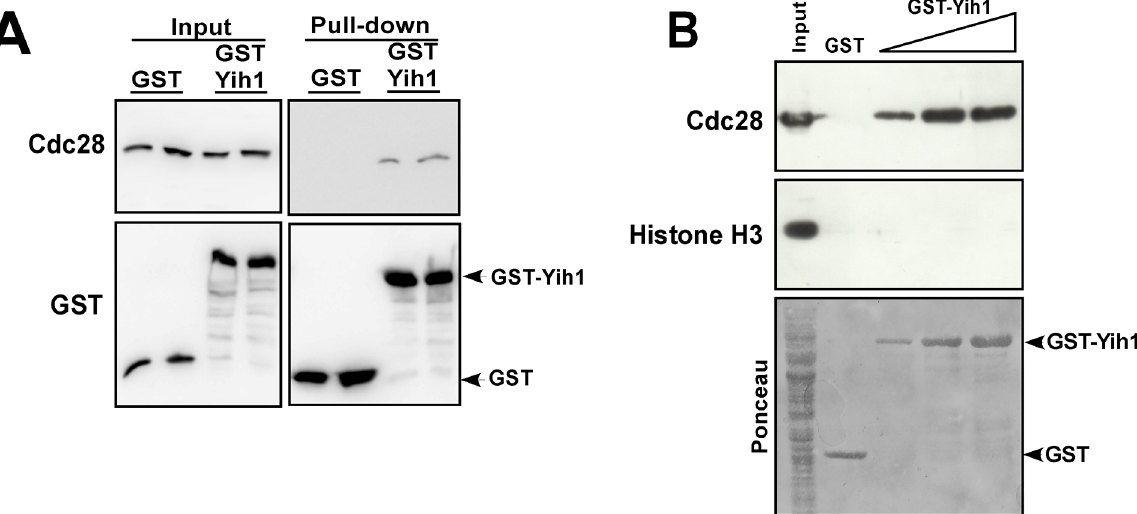
Fig 6. Cdc28 co-precipitates with GST-Yih1. (A) In vivo GST-pull-down assay. yih1 Δ strains (MSY-Y2) expressing GST-Yih1 or GST alone from the galactose inducible promoter were grown to log-phase and harvested. Equal amounts of WCEs (2 mg) were subjected to glutathione-mediated GST pull- down assays. The precipitates (100% of the bound proteins – right-panel) and the input (1/100 th of the input – left panel) were assessed by immunoblot to detect the indicated proteins. (B) GST-Yih1 purified from E . coli co-precipitates endogenous Cdc28 from yeast WCEs. Full-length Yih1 fused to GST or GST alone were expressed in E . coli , purified, immobilized on glutathione-Sepharose beads and incubated with equal amounts of glutathione-Sepharose pre- cleared WCEs (1.25 mg) prepared from a yih1 Δ strain (MSY-Y2). After extensive washes the precipitates (100% of the bound proteins) and the input (1/50 th of the input) were analyzed by immunoblot to detect the indicated proteins. The Ponceau staining of the membrane is shown (lower panel). One representative blot from two independent experiments performed in duplicate is